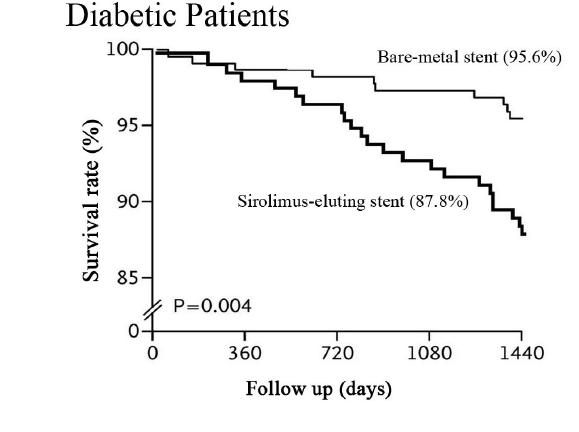
Fig. 2 - Analysis of long-term survival of diabetic patients after implantation of sirolimus-eluting stents or bare-metal stents